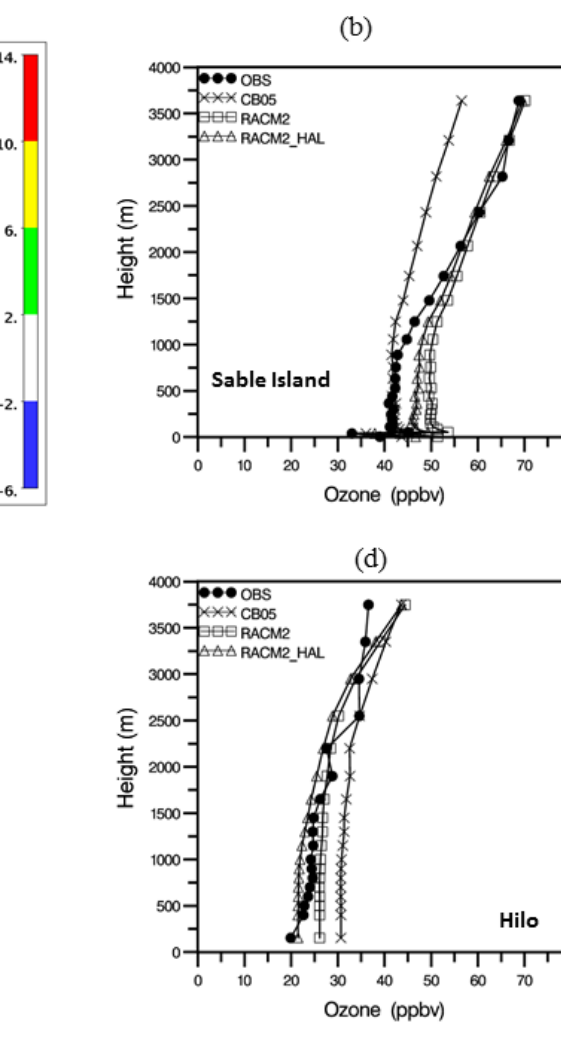
Figure 12. Differences in simulated O 3 distributions using the RACM2 and CB05TU gas-phase chemical mechanisms in the hemispheric CMAQ model. (a) Mean difference (RACM2 minus CB05TU) in monthly mean surface-level O 3 (ppb) for August 2006. Comparisons of mean (for August 2006) O 3 mixing ratio vertical profiles simulated with the CB05TU and RACM2 mechanisms with ozonesonde measure- ments at (b) Sable Island, Nova Scotia; (c) Trinidad Head, California; and (d) Hilo, Hawaii. RACM2_HAL is from a simulation in which the RACM2 mechanism was augmented with halogen chemistry (described in Sect.